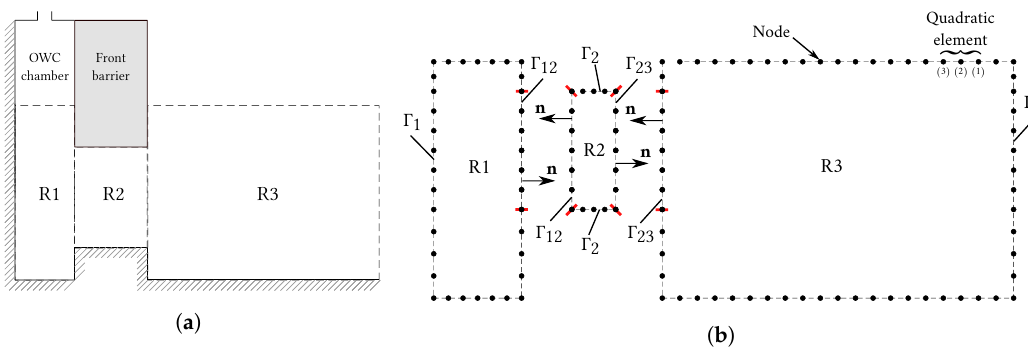
Figure 5. Boundary element discretization of the composite domain. ( a ) Separation of the BVP into three regions. ( b ) Discretization of the three regions.